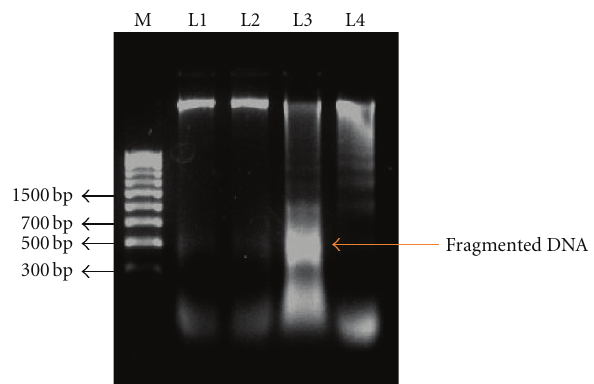
Figure 8: E ff ect of quercetin on DNA fragmentation in hippocam- pus of PCBs-exposed adult wister rats. Each bar represents mean ± SEM of 6 animals. Statistical significance is at P < 0 . 05 (a: Control versus others; b: Quercetin versus PCB, PCB + Quer; c: PCB versus PCB + Quer). M: 100bp Marker; L1: Control; L2: Quercetin; L3: PCB;